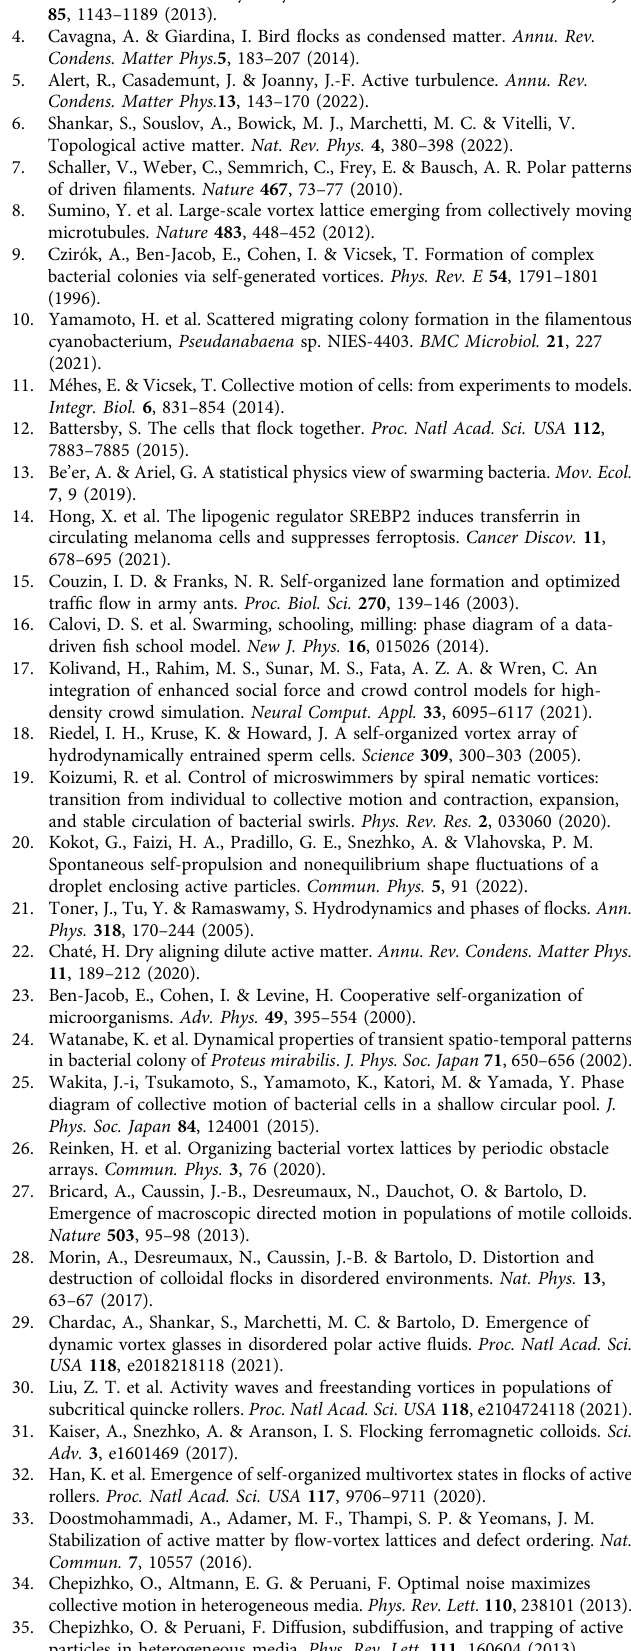
Table 2 Criteria used when determining the order parameters for each